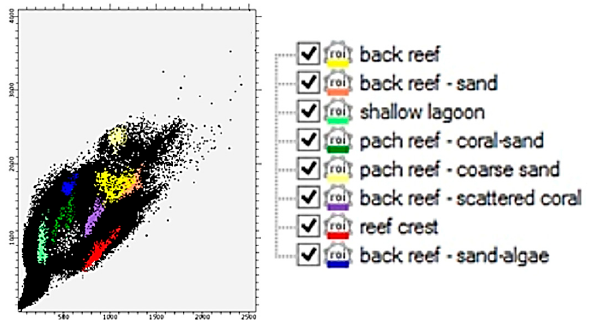
Figure 8. Scatter plot of the coral reef class coverage, showing a high classes separability.